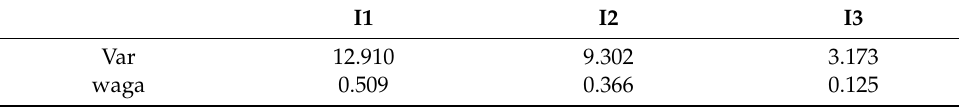
Table 5. Variances and weights used to construct synthetic indicator S3.